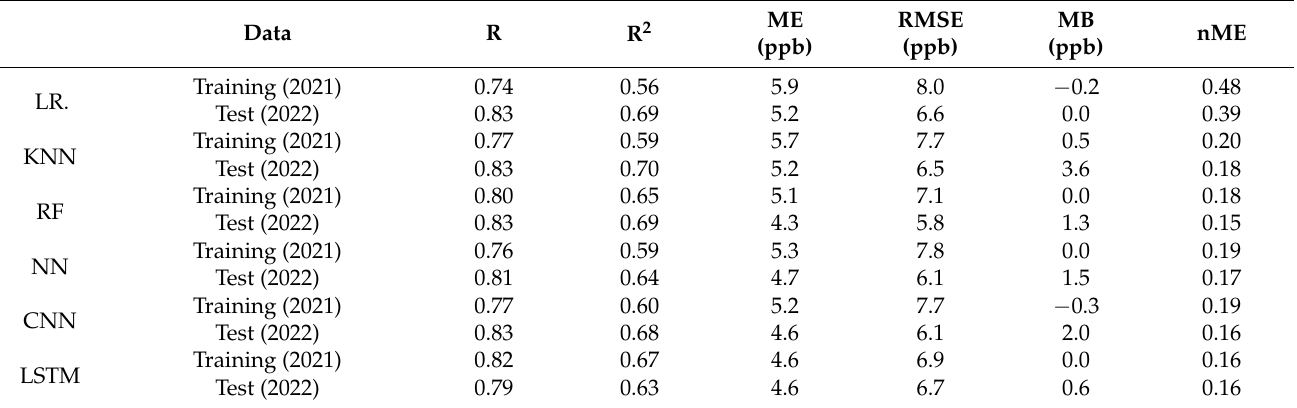
Figure 7. Time series of O 3 concentrations for two 7-day periods of the test set (2022). The uncorrected O 3 low-cost sensor reading is displayed with a blue line, the RF-corrected O 3 estimation is displayed with a black line, and the reference O 3 concentration is displayed with a red line. Table 6. Agreement metrics between the reference O 3 concentrations and the corrected ENSENSIA